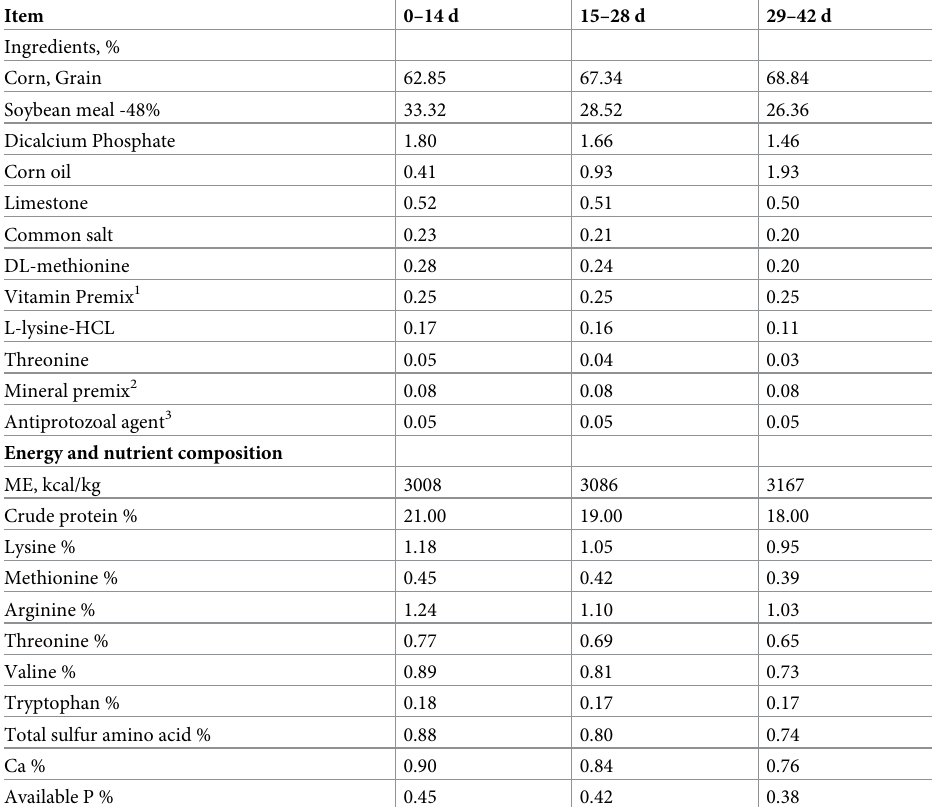
Table 1. Composition and calculated contents of the experimental diets.